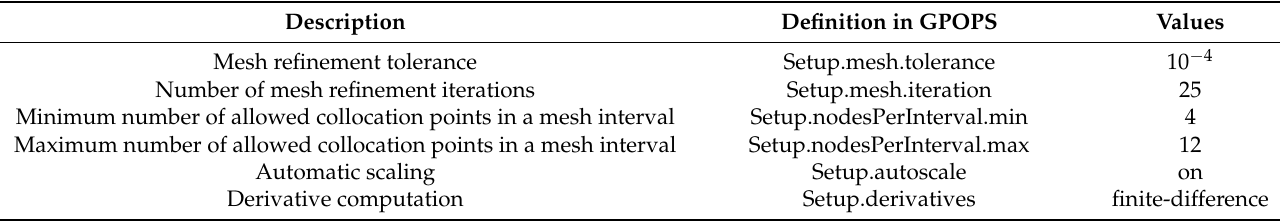
Table 4. Main setting